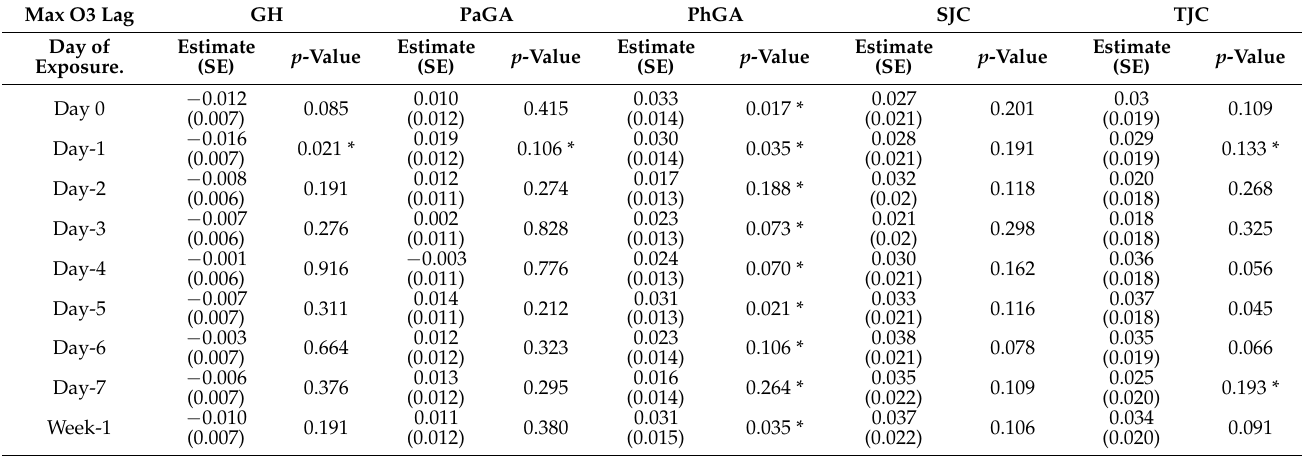
Table A8. Associations between O 3 short-term exposure and RA disease